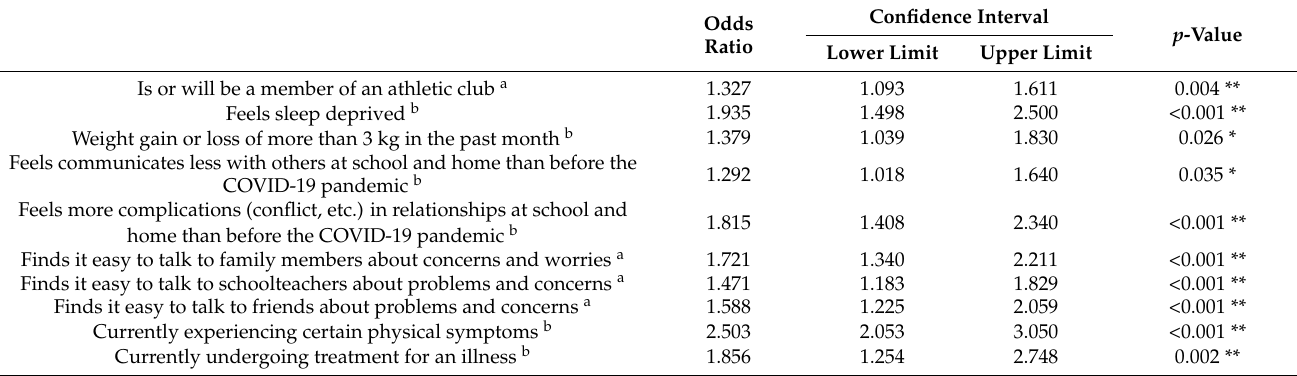
Table 3. Odds ratios of living conditions contributing to “psychological distress”.